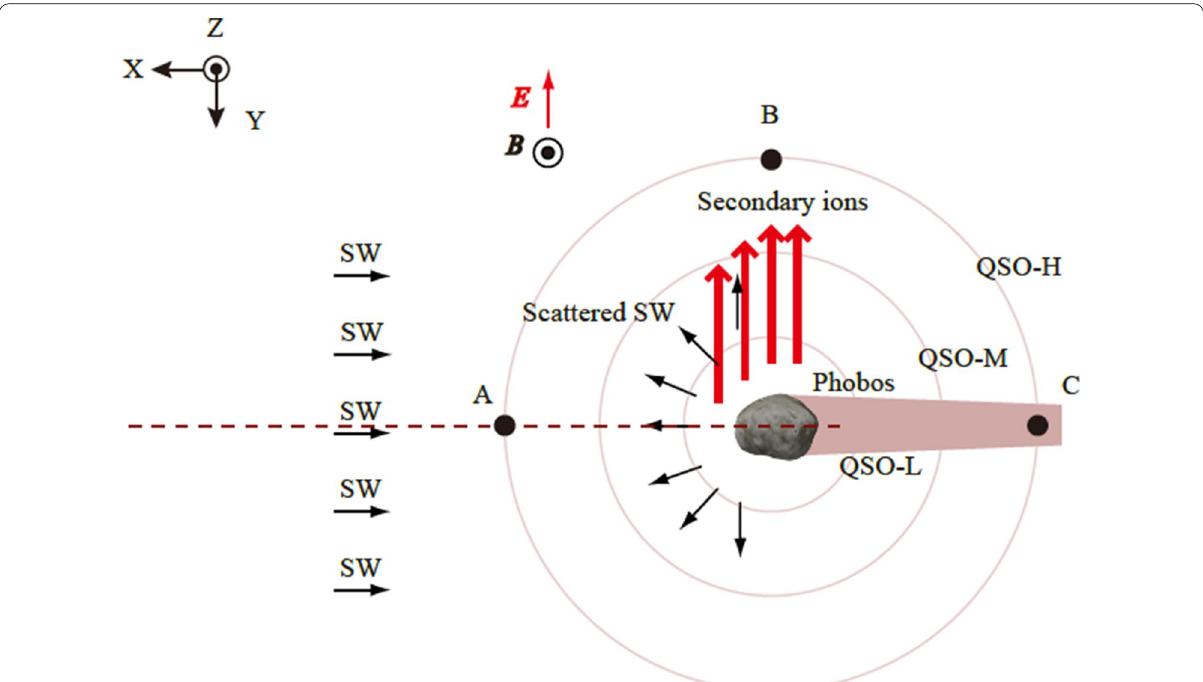
Fig. 14 Observation configuration of MSA in the Phobos‑centric Solar Ecliptic coordinates. The Phobos‑centric Solar Ecliptic coordinate system has the X ‑axis pointing from Phobos towards the sun, the Z ‑axis parallel to the ecliptic northern pole, and the Y ‑axis determined in the right‑handed system. In both panels, B and E indicate the magnetic and electric fields of the SW, respectively. The magnetometer measures B , while E is derived from E = − V × B , where V denotes the SW velocity nearly towards the X −